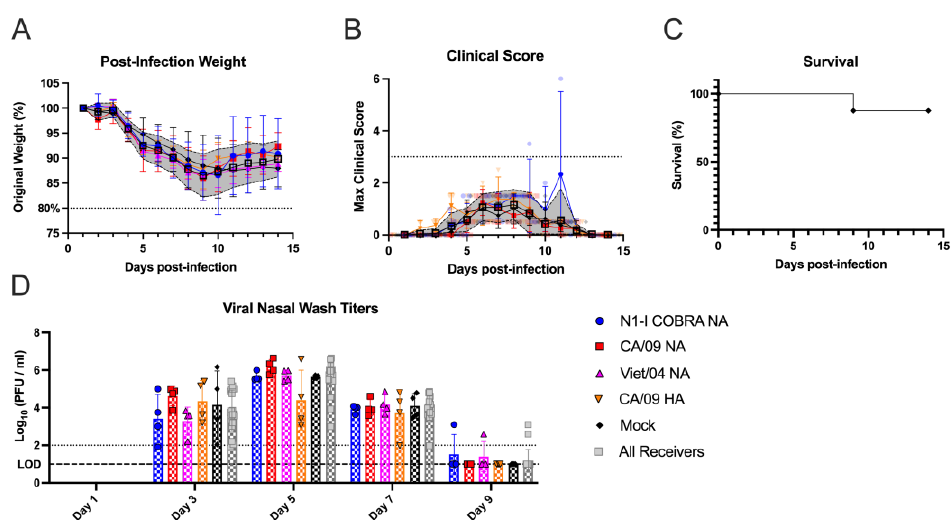
Figure 8. Vaccination of contact transmitting ferrets did not limit the transmission to other ferrets or affect the receiving ferret’s clinical or viral outcomes. Naïve ferrets were co-housed one day after the CA/09 intranasal infection of ferrets vaccinated with different influenza protein antigens (see legend; Figure 1B). ( A ) The normalized weights, regardless of the transmitting ferret’s vaccination status, were the not significantly different, and the combination of all the naïve receivers is shown in grey with the ‘All Receivers’ group. The clinical scores ( B ), and survival ( C ) were recorded over the course of the study and shown as All Receivers. ( D ) The viral lung titers determined through plaque assay were also unsignificant. The maximum clinical scores from the morning and evening checks were displayed with a score of three or greater indicating clinical endpoint. Individual ferret clinical scores are shown with the line connecting the mean score, and the individual points with lower opacity. The grey shaded regions for weight and clinical score indicate the standard error of all receivers combined. Mixed effects analysis or two-way ANOVA with repeated measures were used for statistical analysis. All error bars represent standard deviation. The minimum weight before clinical endpoint was 75%, with 80% denoting an increase in clinical scoring.